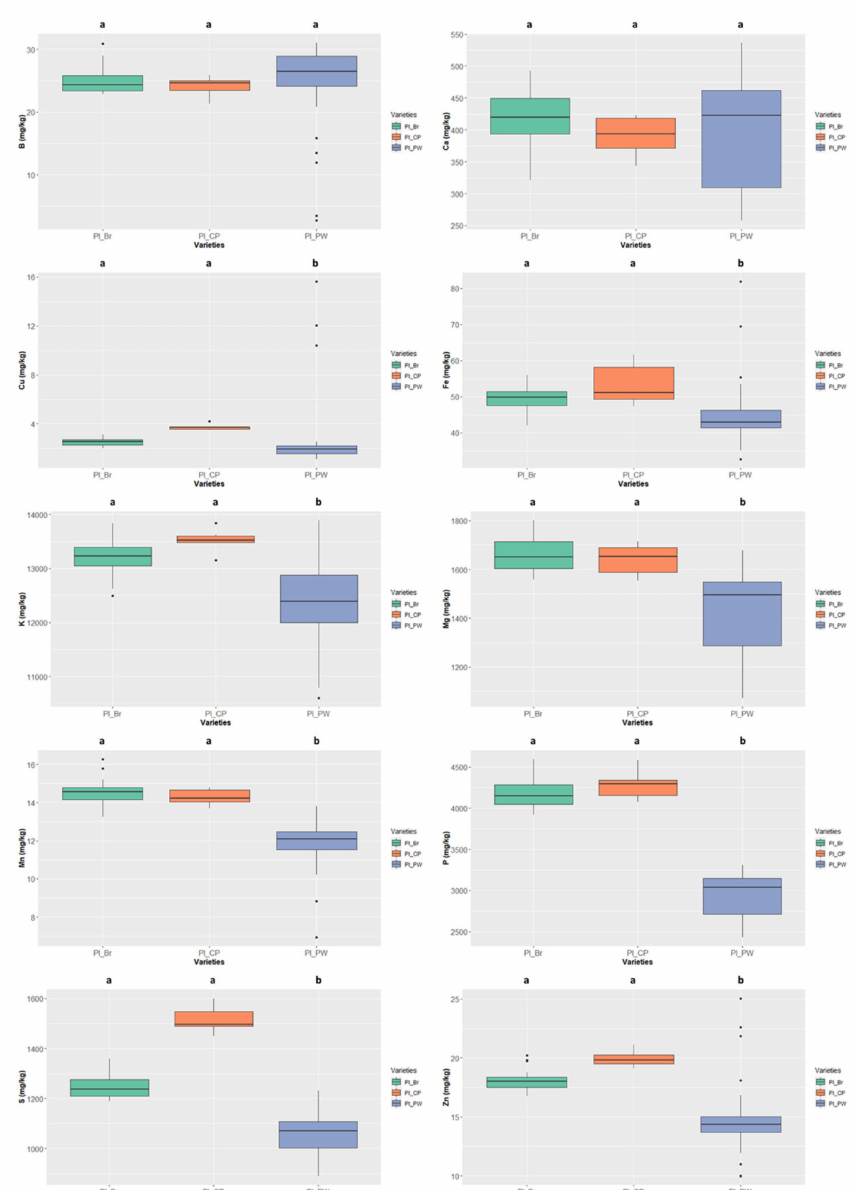
Figure 9. Variation of the content of the 10 minerals quantified in the different colour types of Phaseolus lunatus . The box represents the 25th, 50th (median), and 75th percentiles, while the whiskers represent the 10th and 90th percentiles with minimum and maximum observations. The dots represent the outliers. Different lower-case letters indicate significance differences ( p < 0.05) between